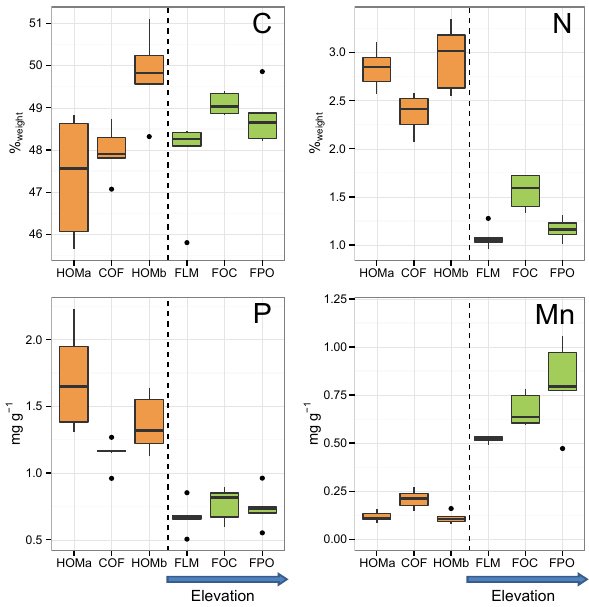
Figure 4. Contents of selected elements (C, N, P, Mn) in leaf litter from six ecosystems at Mt. Kilimanjaro. Medians, interquartile dis- tances and extreme values are displayed as bold lines, boxes with whiskers and dots, respectively. Managed (left) and natural (right) ecosystems are separated by dashed